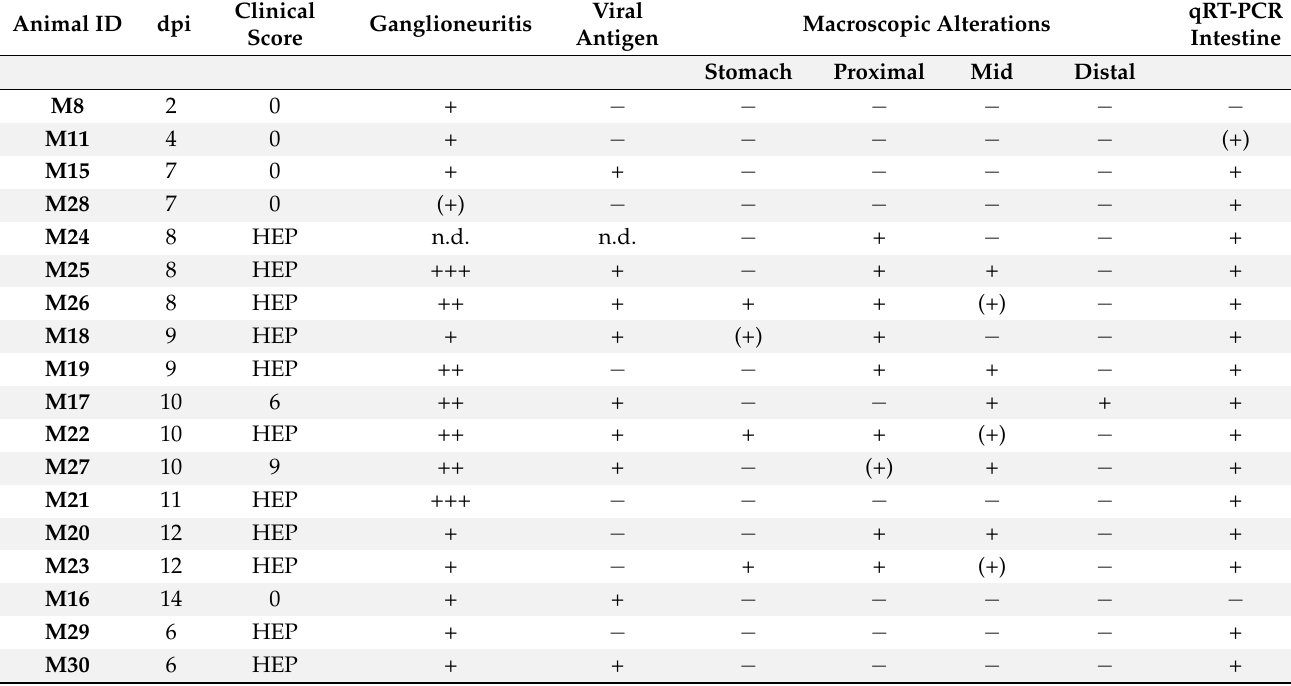
Table 2. Overview of mice with enteral ganglioneuritis (15 of 22) after subcutaneous TBEV infection with the day of euthanasia after infection and clinical score (HEP= humane endpoint). The severity degree of ganglioneuritis ((+) = minimal, + = mild, ++ = mild to moderate, +++ = moderate, − = absent, n.d.= not detected), presence of viral antigen (+ = present, − = absent), presence of macroscopic alterations in GI tract regions (+ = present, − = absent) and status of viral RNA copies presence in intestine measured by qRT-PCR (+ = present, − = absent) are given for each animal.. M29 and M30 were intracerebrally infected positive control mice. No enteral ganglioneuritis, TBEV antigen, RNA or macroscopical alterations were found in the mock-infected negative control mice (data not